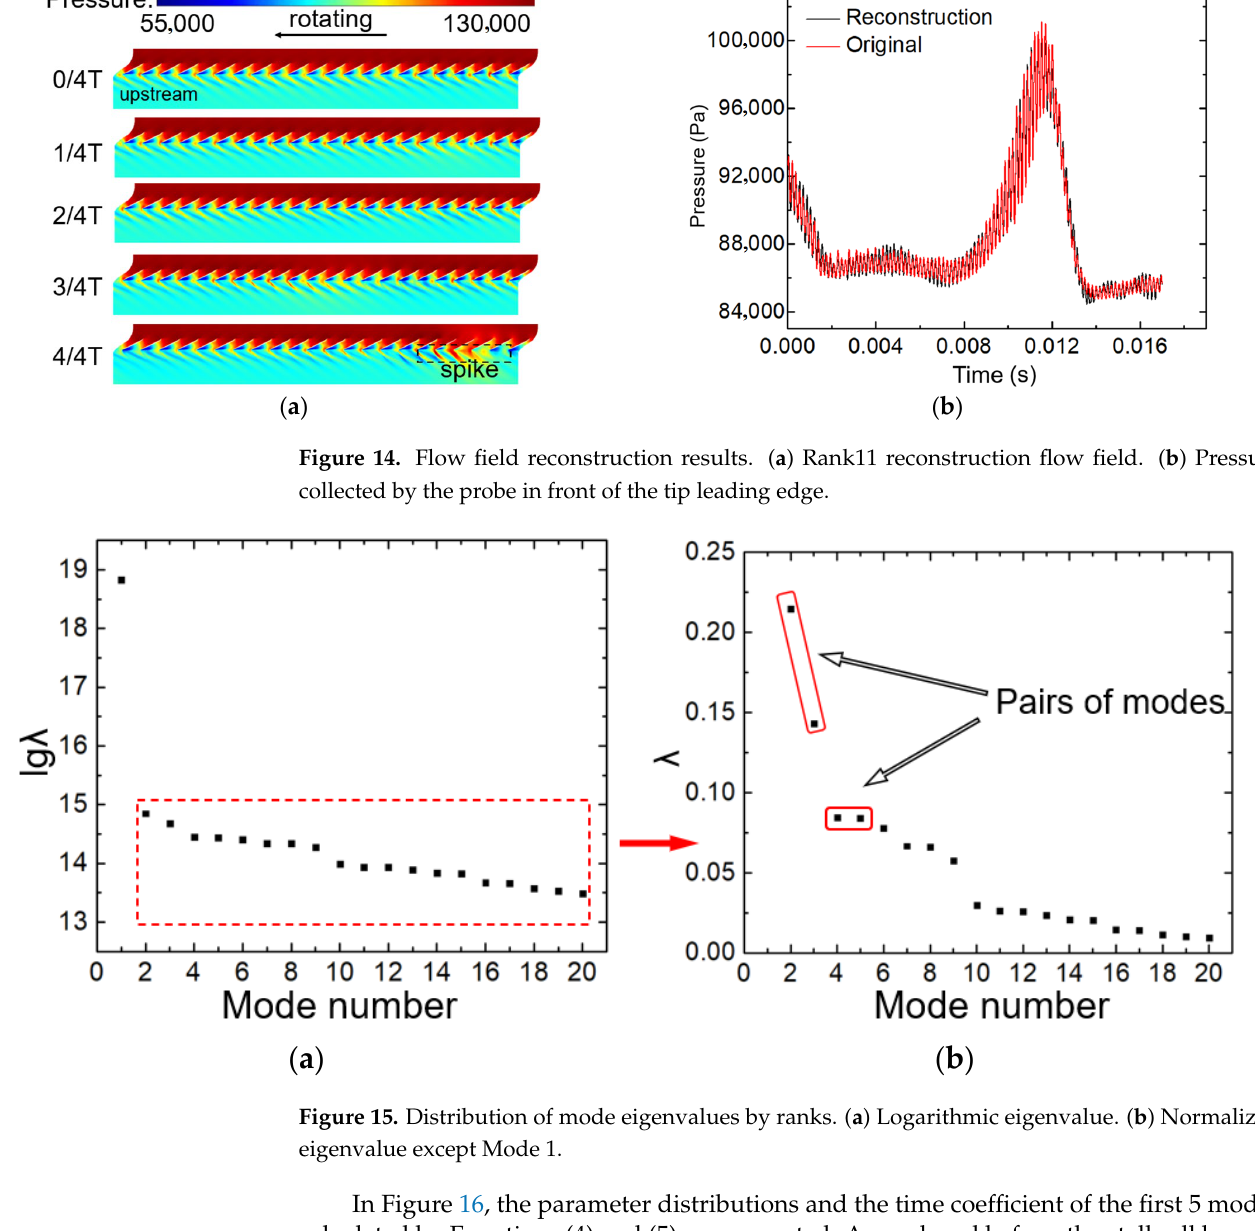
Figure 15. Distribution of mode eigenvalues by ranks. ( a ) Logarithmic eigenvalue. ( b ) Normalized eigenvalue except Mode 1.